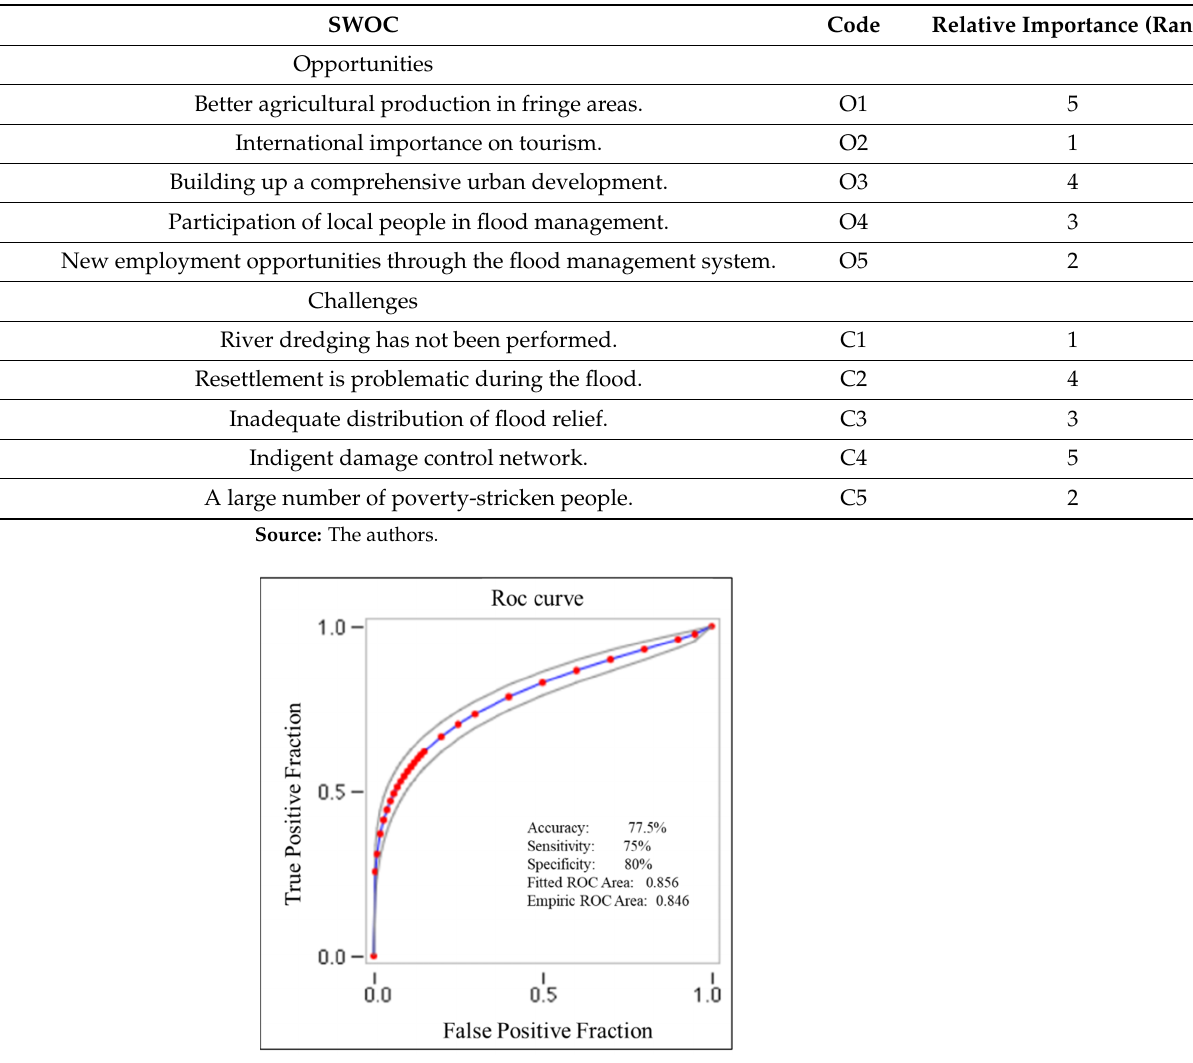
Figure 63. Validation of composite flood vulnerability index using ROC-AUC (2000).